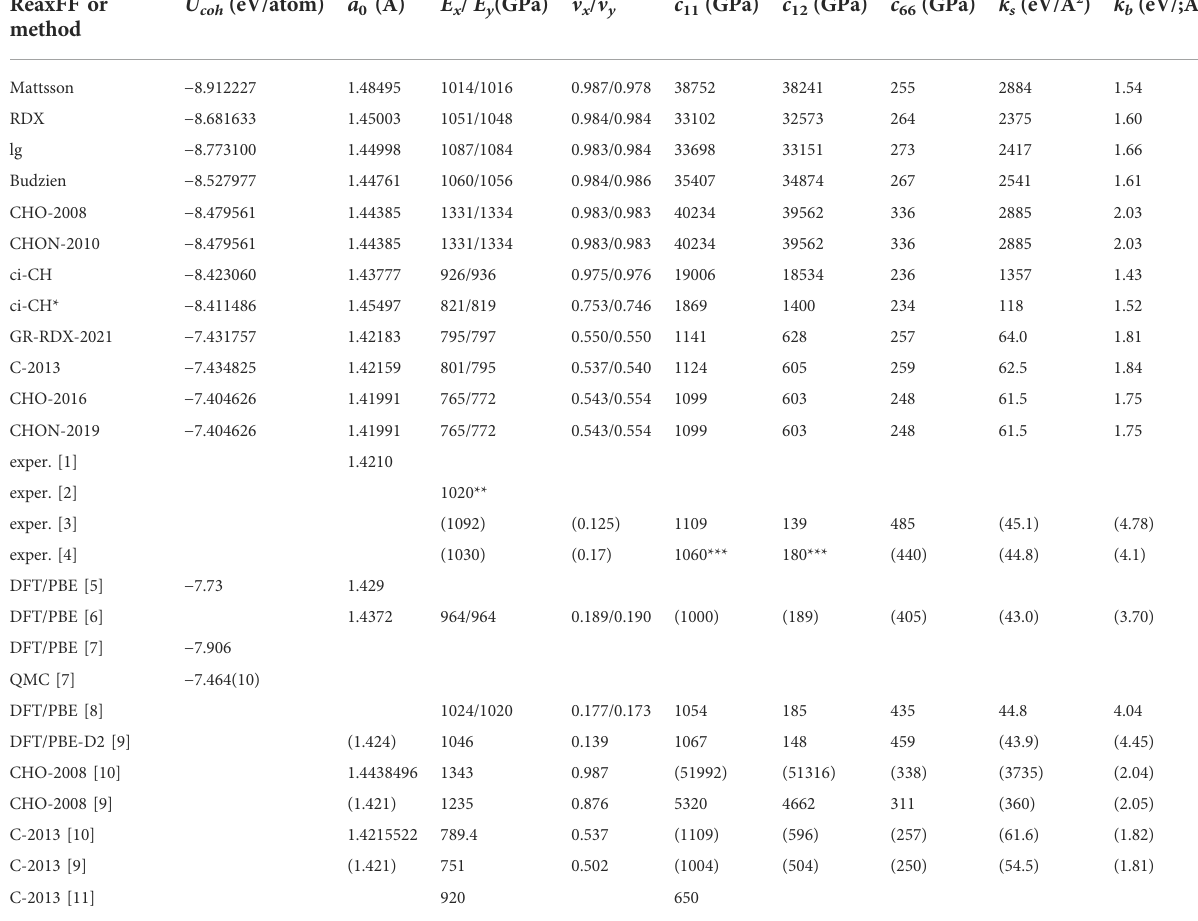
TABLE 1 Predictions of the ReaxFF potentials considered in the present study for the structural, energetic and mechanical properties of graphene. 1) Cohesive energy U coh and 2) bond length a 0 of the optimum energetically graphene structure, 3) Young ’ s modulus E x = σ xx / ε xx and 4) Poisson ’ s ratio ν x = − ε yy / ε xx foruniaxialstrain ε xx along x -direction,5)Young ’ smodulus E yy = σ yy / ε yy and6)Poisson ’ sratio ν y = − ε xx / ε yy foruniaxialstrain ε yy along y -direction,6)springconstant k s forbondstretchingand7) k b forbondanglebending8)-10)theelasticconstants c is the shear modulus, and λ and μ the fi rst and second Lamé ’ s coef fi cients, respectively). Directions x and y correspond to the arm chair and zig- zag directions, respectively. Ab initio and experimental values are included for comparison. The k s , k b , c 11 , c 12 and c 66 values in parenthesis, have been calculated by us, based on the average of the provided E and ν values. [1]: (Lynch and Drickamer (1966)), [2]: (Lee et al. (2008)), [3]: graphite (Bosak et al. (2007)), [4]: graphite (Blakslee et al. (1970)), [5]: AIMPRO (Ivanovskaya et al. (2010)), [6]: Siesta (Fthenakis and Menon (2019)), [7]: Quantum Espresso and QM-CPACK (Shin et al. (2014)), [8]: Quantum Espresso (Fthenakis and Lathiotakis (2015; 2017)), [9]: (Jensen et al. (2015)) [10]: (Lebedeva et al. (2019)) [11]: (Qian et al. (2021)), * 2nd minimum, ** ±150, ***